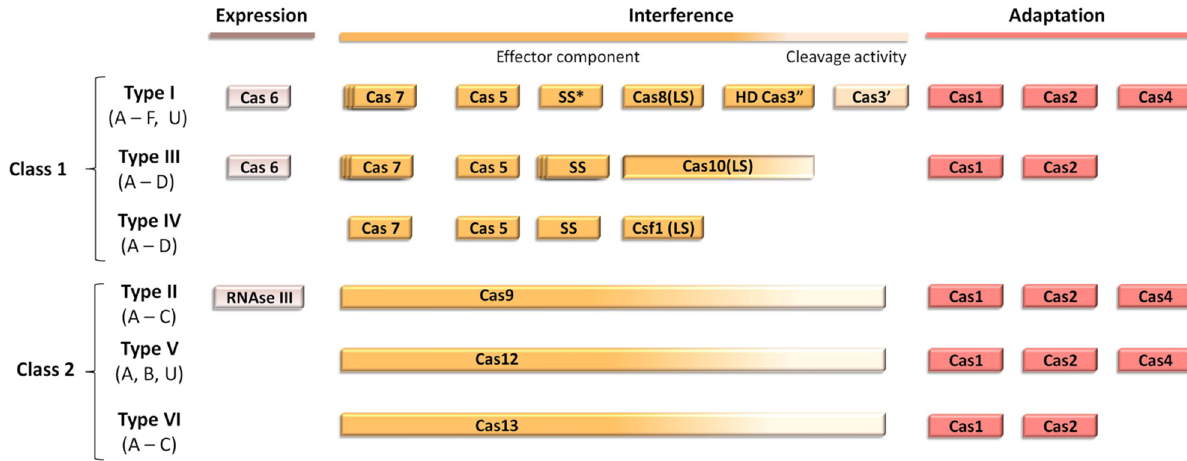
Figure 1. Modular organization of the different classes of CRISPR-Cas systems. Scheme adapted from Ishino et al. SS* indicates that the putative small subunit (SS) might be fused to the large subunit in several type I subtypes [13].